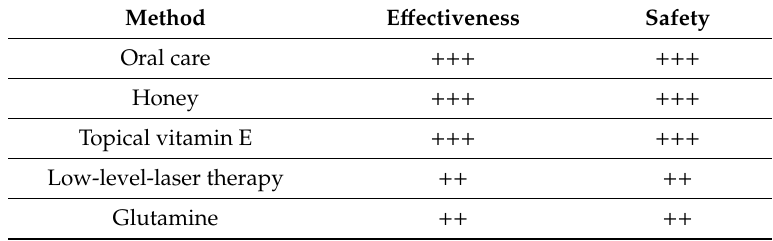
Table 5. Suggestions regarding prophylaxis of radiation-induced oral mucositis.